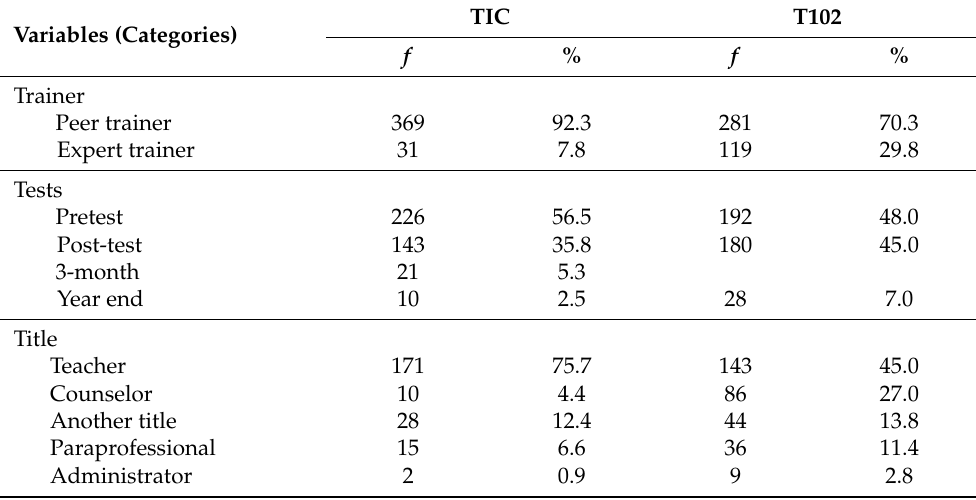
Table 1. Frequencies for nominal and ordinal independent and dependent variables ( n =